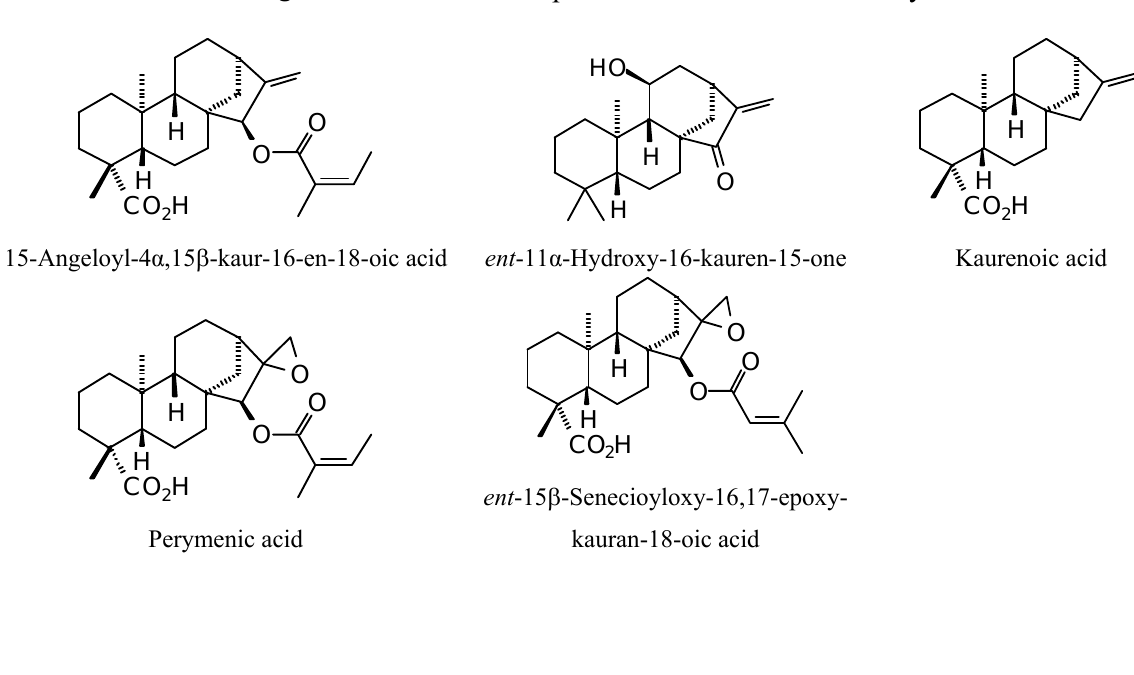
Figure 13. Kaurane diterpenoids examined in this